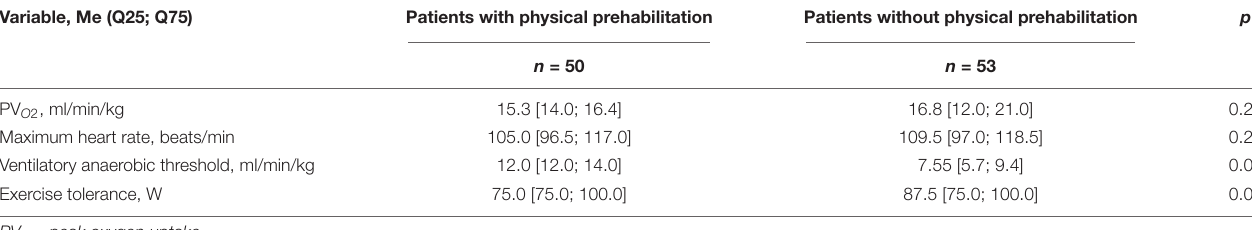
TABLE 2 | Cardiopulmonary exercise testing (CPET) indicators in patients who did and did not undergo a course of physical prehabilitation. Variable, Me (Q25; Q75)